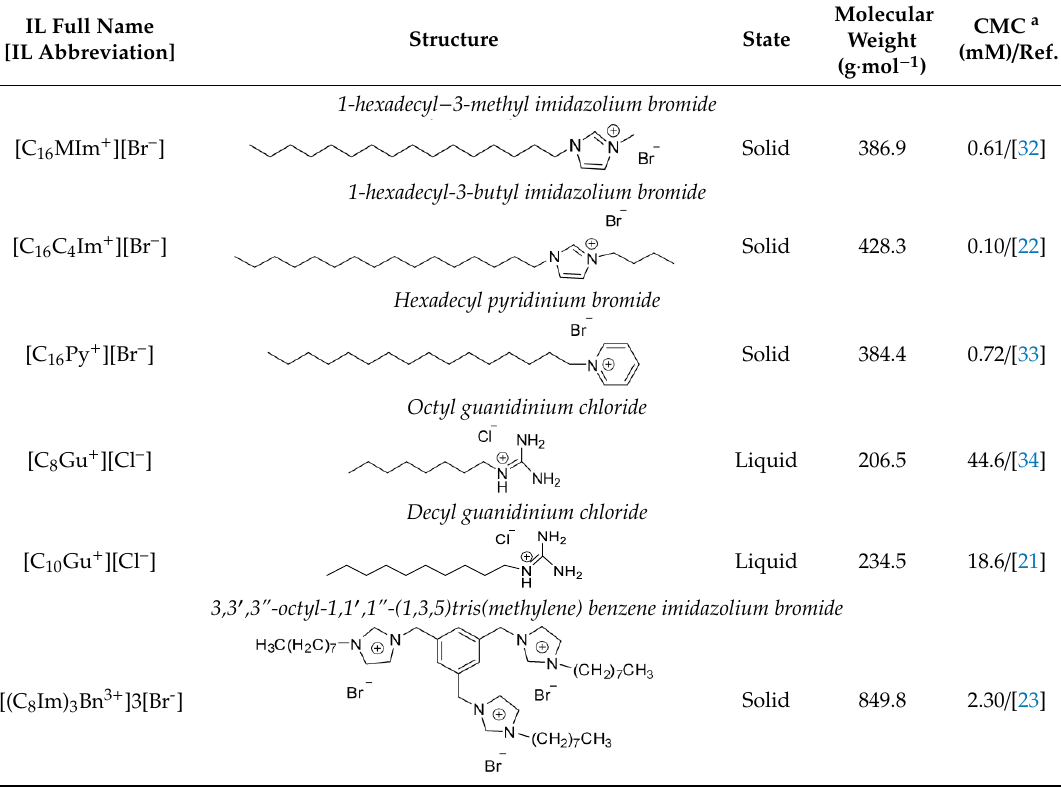
Table 1. Several characteristics of IL-based surfactants evaluated in the IL-MA-SLE-HPLC-PDA method for the extraction of flavonoids from plants.